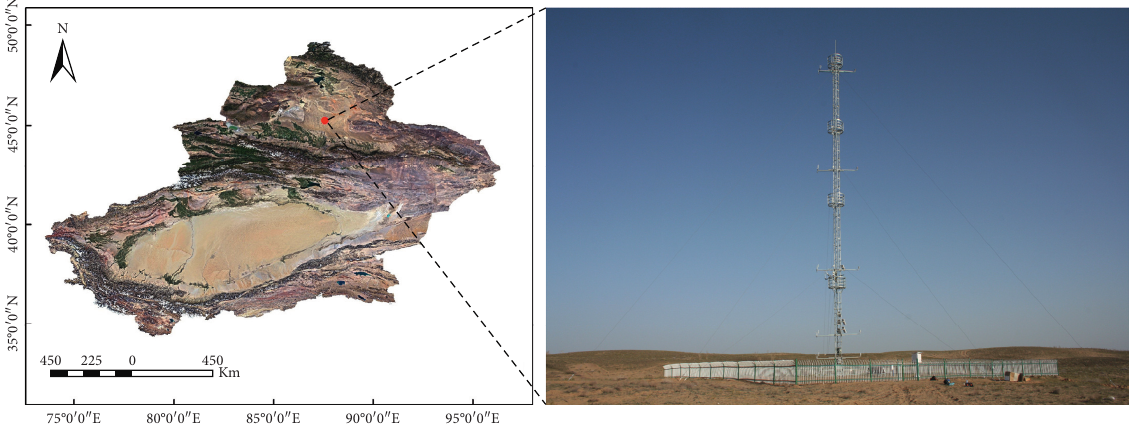
Figure 1: The study area and KLML land-atmospheric interaction observation station of the Gurbant¨ungg¨ut Logan, UT, USA) at 1 Hz intervals and averaged at 10 s, 1 min,